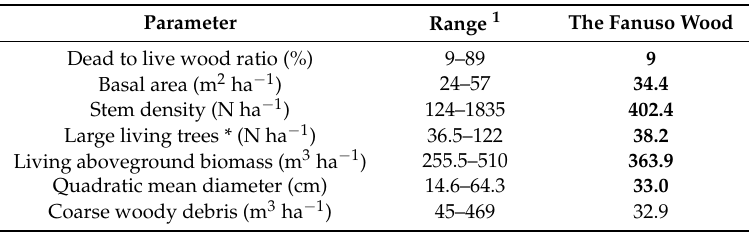
Table 5. Comparison between the mean values recorded in a recent review about old-growth temperate forests and the values of the investigated forest